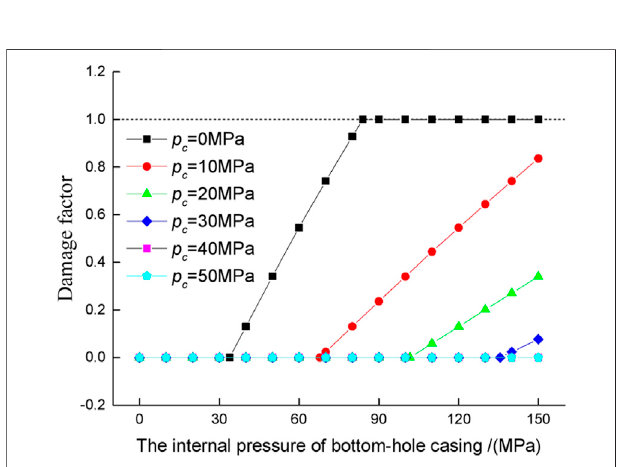
FIGURE 8 | Relationship between the damage factor of the cement sheath and casing